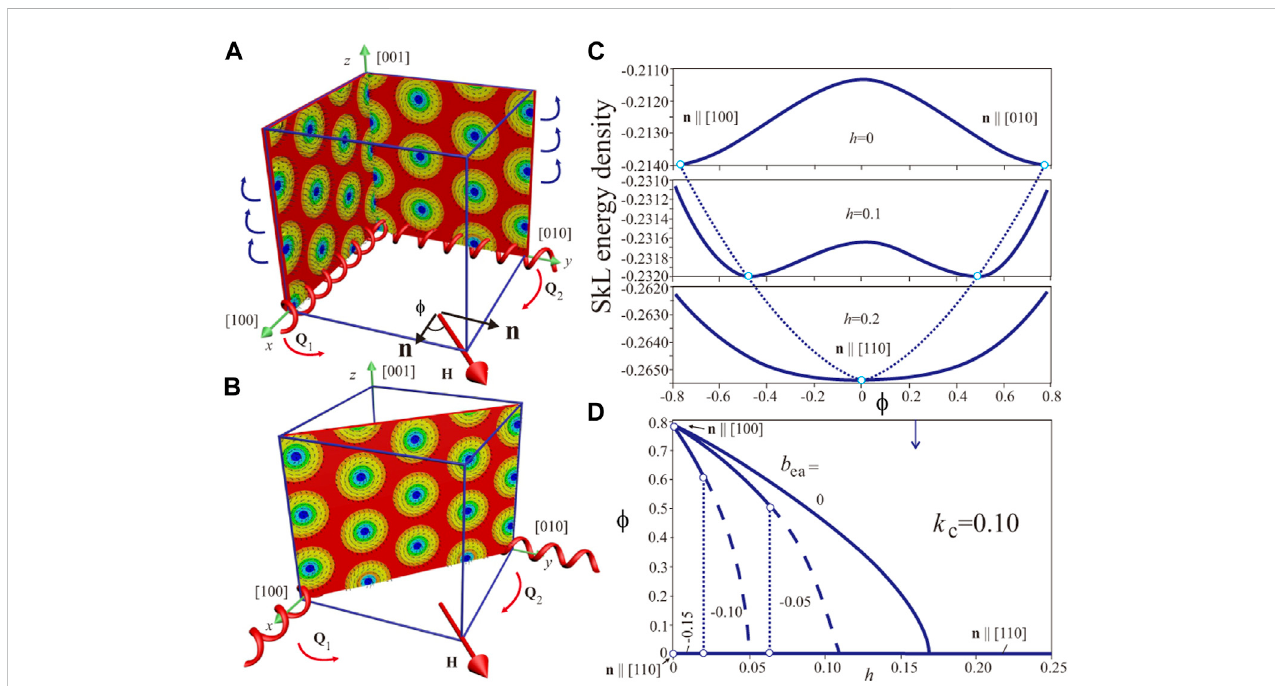
FIGURE 6 (color online) (A) Schematics of hexagonal skyrmion lattices occupying the {100} planes for the cubic anisotropy with easy 〈 001 〉 axes. In an applied magnetic fi eld h (cid:1) [110] the oblique SkLs orient perpendicular to the fi eld (B) , i.e., occupy the plane (110). The fi eld dependence of the angle ϕ between the skyrmionaxesandthe fi eldshownin (D) exhibitseitherasmoothrotation(for b ea =0)orajump-liketransition(for b ea < 0).TheSkLenergydensity,givenin (C) for k c = 0.1, b ea = 0 in dependence on the fi eld, is minimized with respect to the direction of n .